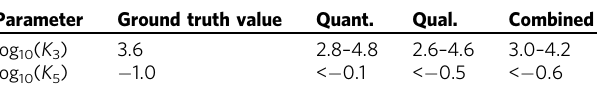
Table 1 Bounds on parameters (in μ M − 1 ) using quantitative, qualitative, or both datasets, assuming a maximum relative objective function value of